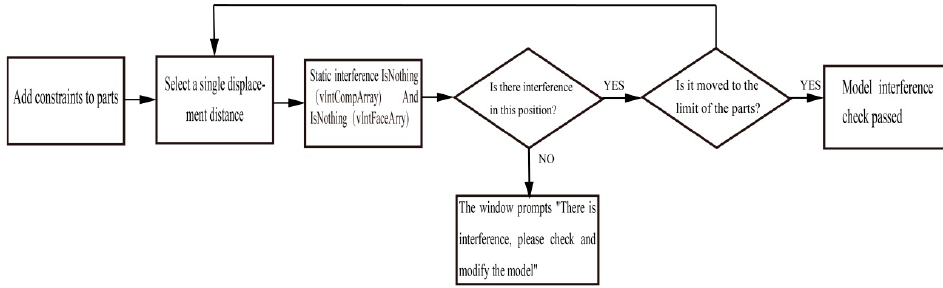
Figure 5. The stacker model interference check process.